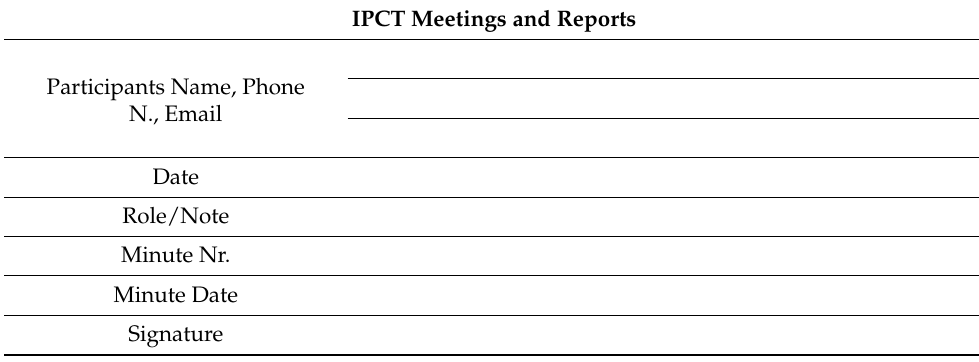
Table 3. A checklist to record IPCT meetings and reports.